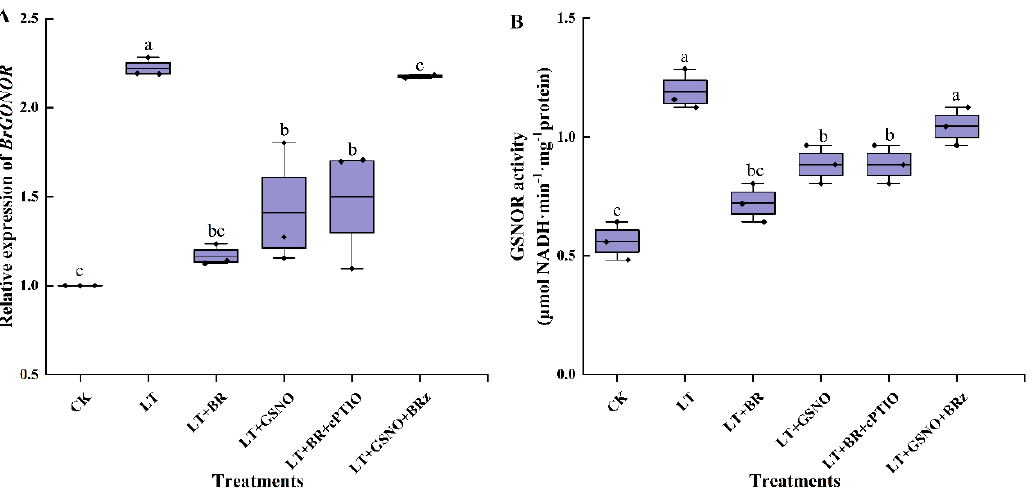
Figure 5. Effects of BR, GSNO, cPTIO and BRz treatments on BrGSNOR gene relative expression levels and GSNOR activity of mini Chinese cabbage under low temperature stress. Five-leaf seedlings were treated with CK (26/18 °C, day/night), LT (4/4 °C, day/night), LT + 0.05 mg/L BR, LT + 50 µM GSNO, LT + 0.05 mg/L BR + 50 µM cPTIO and LT + 50 µM GSNO + 10 µM BRz. After 7 d, relative expression of BrGSNOR gene and GSNOR activity were measured, respectively. ( A ) relative expression level of BrGSNOR gene; ( B ) GSNOR enzyme activity. Different lowercase letters indicate significant differences at the 0.05 level.